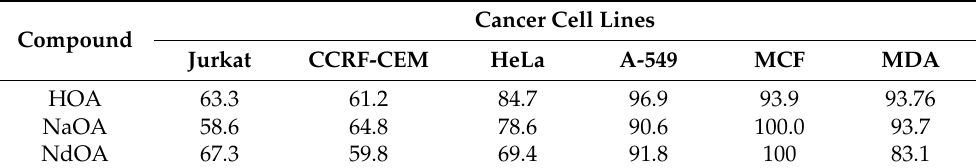
Table 3. Cytotoxicity of the studied compounds at a concentration of 10 − 4 mol · L − 1 (percentage of living cells compared to solvent control (100%)).